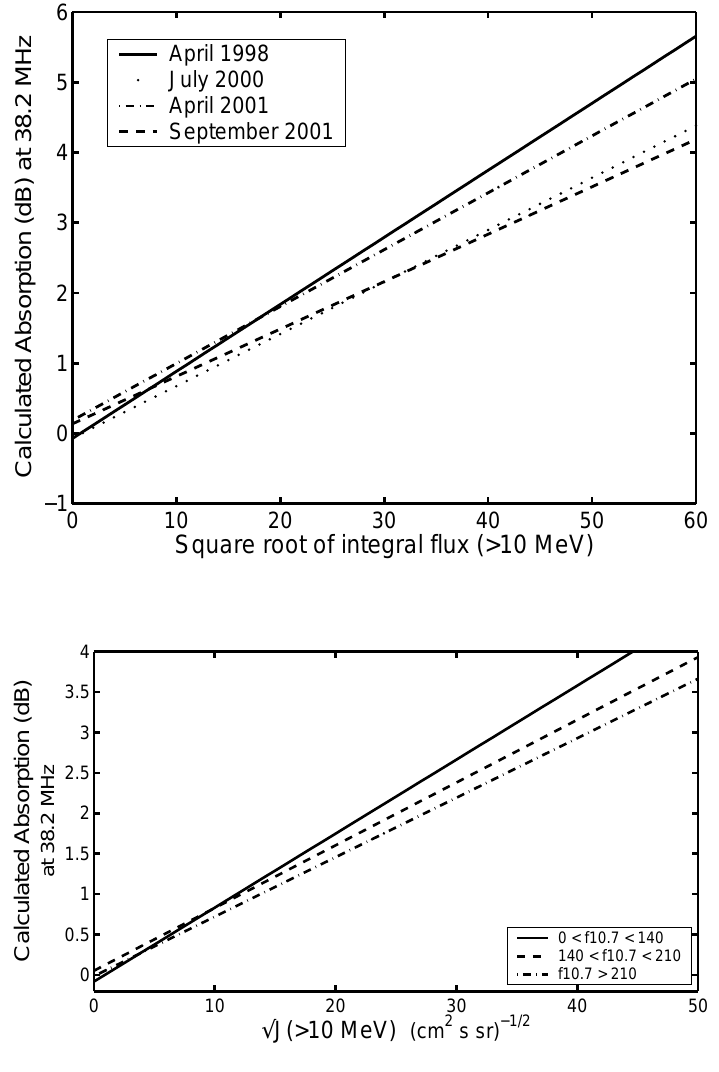
Fig. 10. Three lines are displayed de- picting the relationship between the in- tegral proton flux and the cosmic noise absorption calculated for three ranges of solar activity defined by the f 10 . 7 index. Note that with higher activity the √ J> 10) due to absorption reduces (for a combination of reduced gradient and intercept (for the two higher